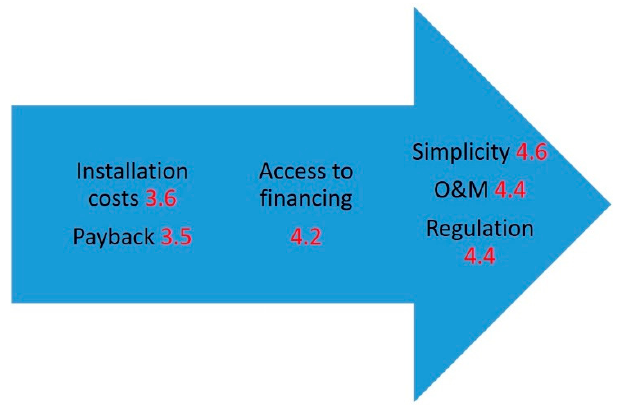
Figure 6. Hypothetical timeline from the beginning to the end of the decision process.